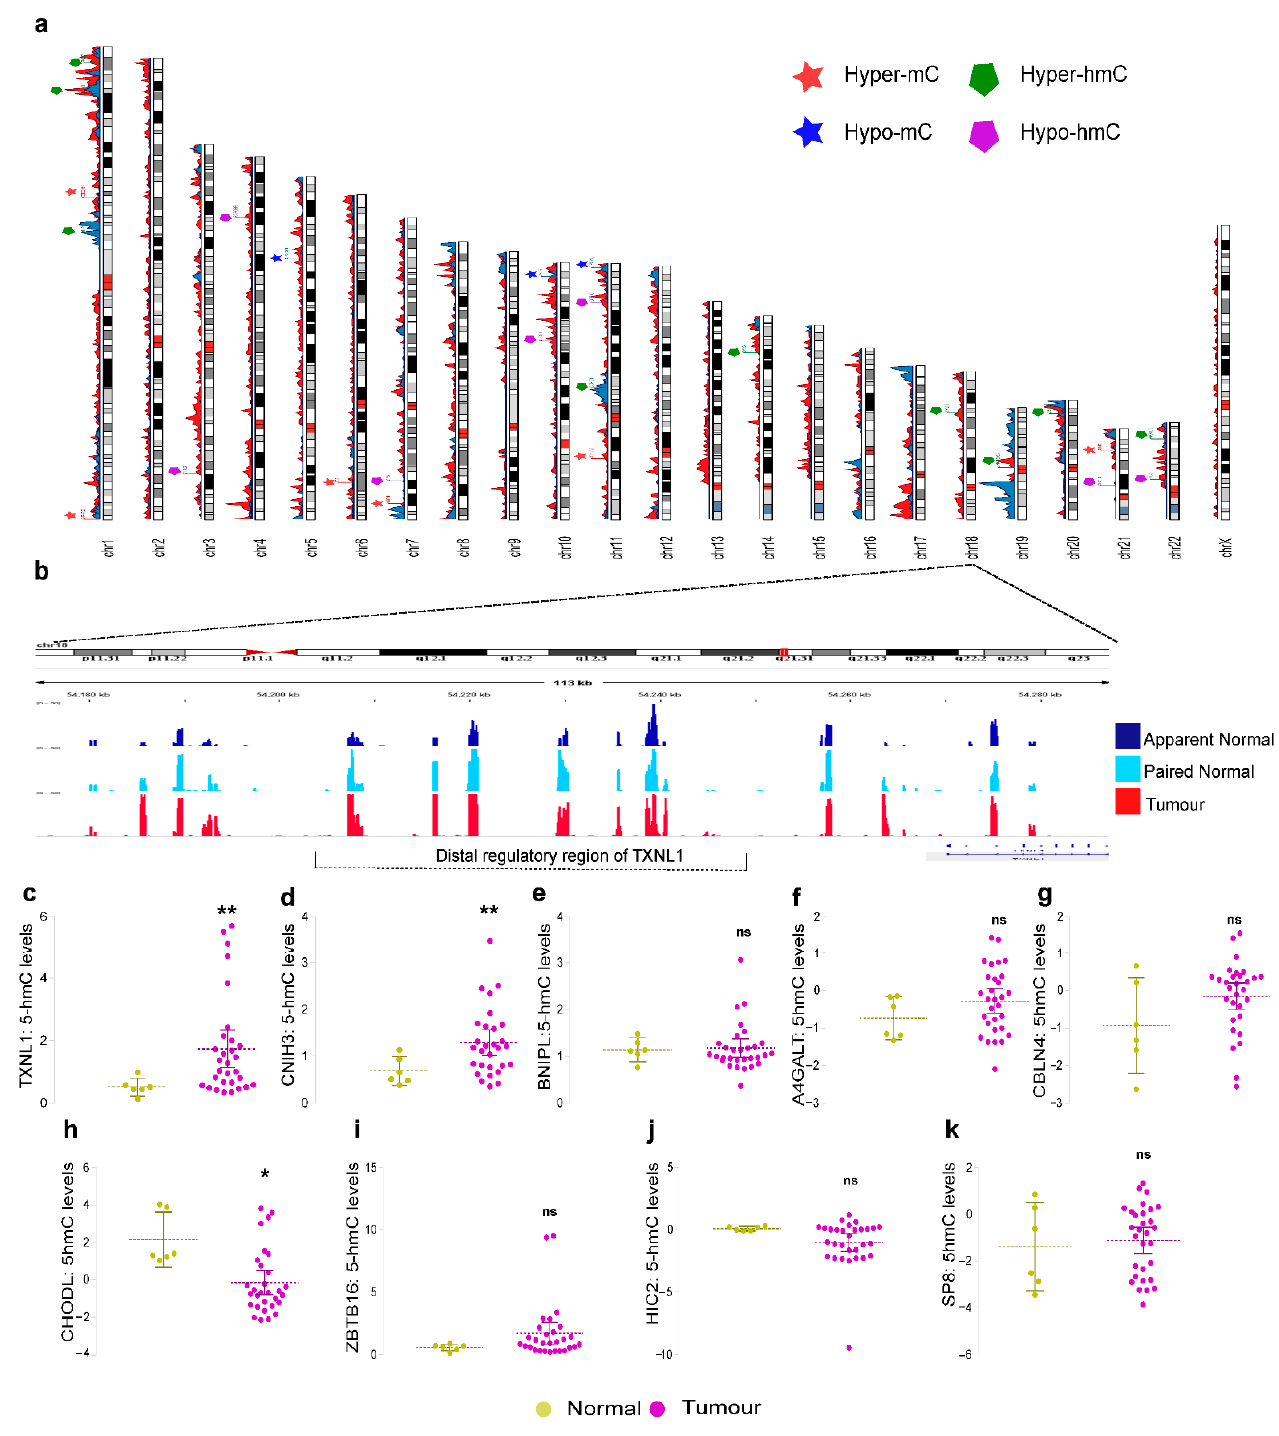
Figure 3. Validation of 5-hmC specific loci in breast tumour and normal samples. ( a ) Ideogram representing DMRs (blue) and DhMRs (red) across all chromosomes and the candidate loci of hyper-mC, hypo-mC, hyper-hmC, and hypo-hmC groups. ( b ) Integrative genome viewer representing the gain of 5-hmC in the distal regulatory region of TXNL1 in tumour, paired normal and apparent normal samples. ( c ) Validation of 5-hmC levels of TXNL1 ( d ) Validation of 5-hmC levels of CNIH3 ( e ) Validation of 5-hmC levels of BNIPL. ( f ) Validation of 5-hmC levels of A4GALT. ( g ) Validation of 5-hmC levels of CBLN4. ( h ) Validation of 5-hmC levels of CHODL. ( i ) Validation of 5-hmC levels of ZBTB16. ( j ) Validation of 5-hmC levels of HIC2. ( k ) Validation of 5-hmC levels of SP8. The p -value of <0.05 was considered statistically significant (** p < 0.001, and * p <